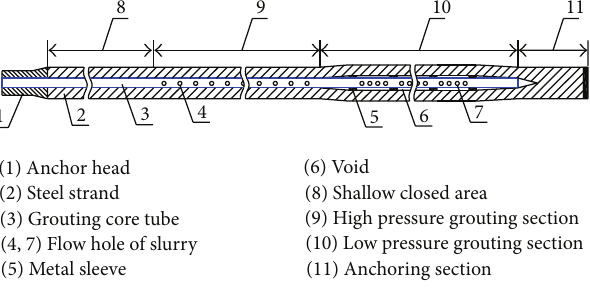
Figure 11: Structure of grouting